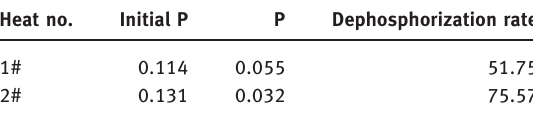
Table 3: Phosphorus content and dephosphorization rate at the first deslagging of two selected heats/mass%.